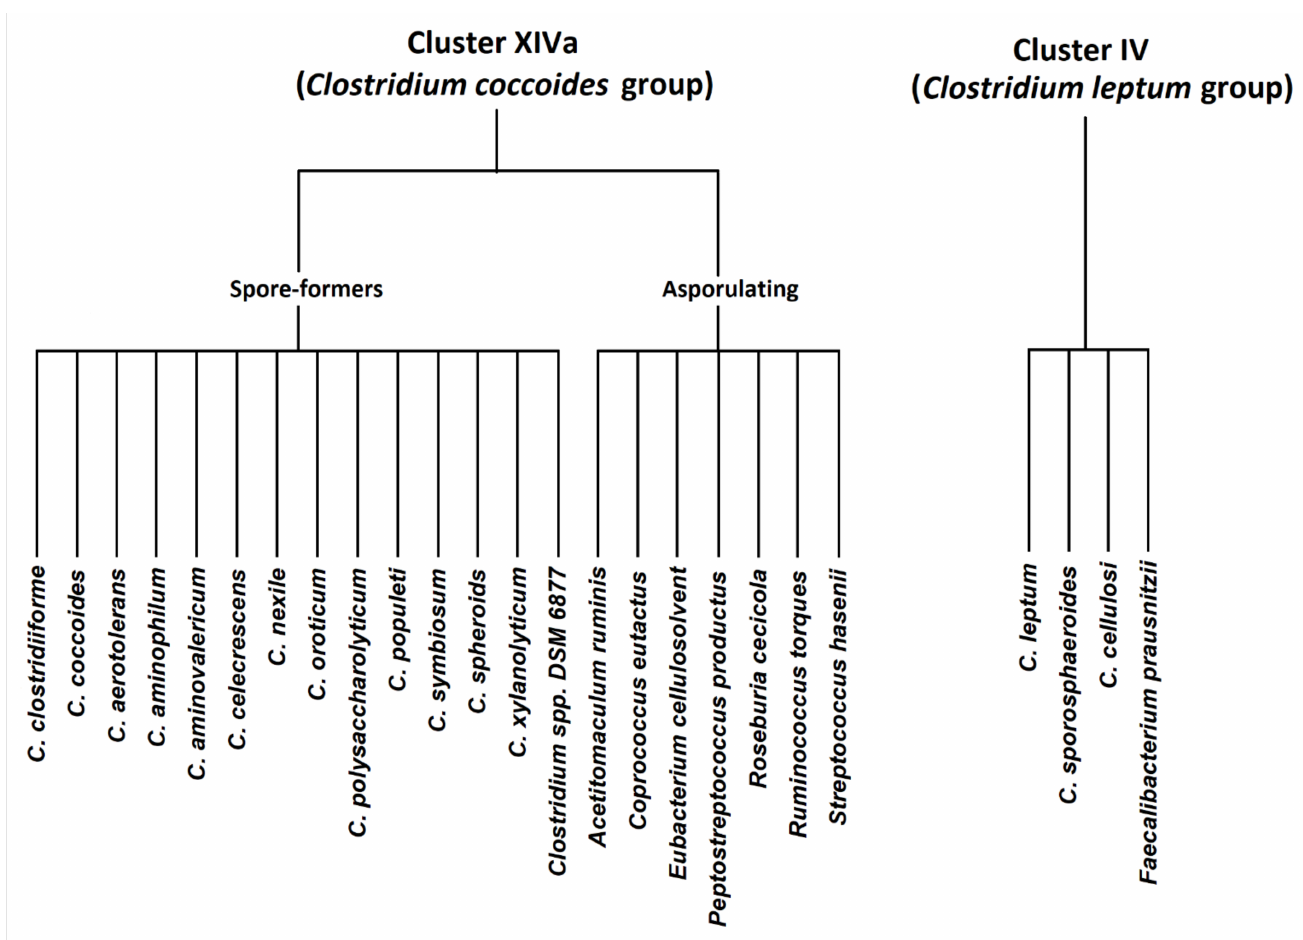
Figure 1. Clostridium coccoides and Clostridium leptum groups—graphical